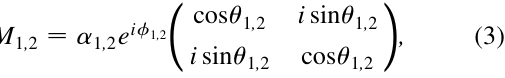
FIG. 3. (a) A generic signal-flow graph modeling the system. The block diagram consists of two JPCs (represented by solid red rectangles) coupled through their idler and signal ports by effective two-port couplers (beam splitters) M 1 ; 2 (represented by dashed green rectangles). The additional coupling between the signal ports of the device and its external ports 1 and 2 is established by introducing effective three-port combiners or splitters (represented by dashed blue rectangles). (b) A detailed version of the signal graph depicted in panel (a). This graph is used in the derivation of Eqs. (5)–(16), (20), and (21) of the theoretical model. It is also used in the calculation of the device response shown in panels (c) and (d) of Fig.